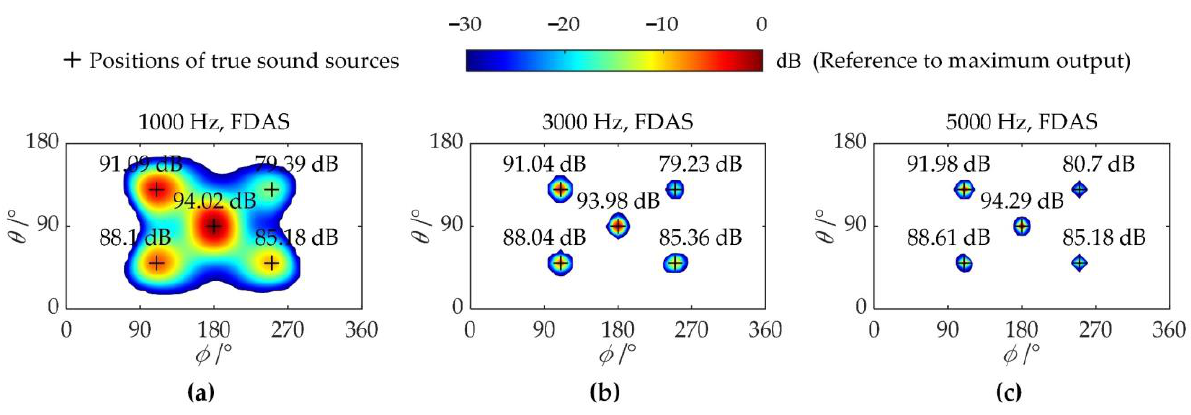
Figure 2. Colormaps of FDAS without noise interference: ( a ) 1000 Hz; ( b ) 3000 Hz; ( c ) 5000 Hz.